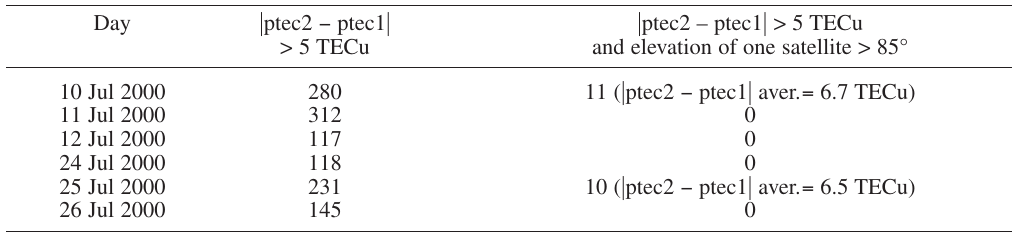
Table 18.I. Number of cases for which conversion errors exceed 5